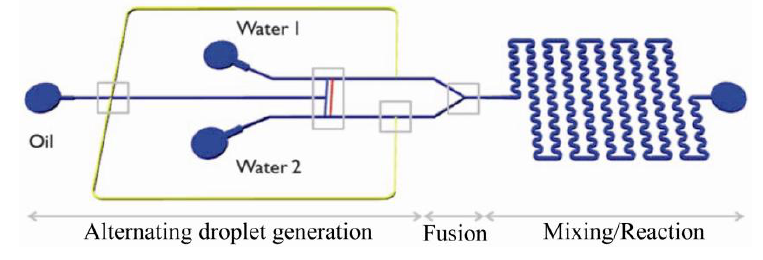
Figure 3. Microfluidic chip with various passive droplet manipulation capabilities. The system includes a droplet-pair generator (double T-junction), a Y-junction for droplet fusion and a winding channel for further mixing. Reprinted from [51] with permission from the Royal Society of Chemistry